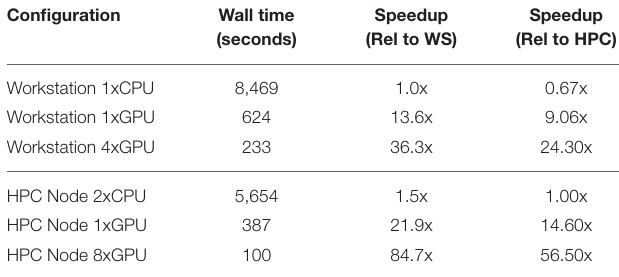
TABLE 2 | Benchmark timing tests